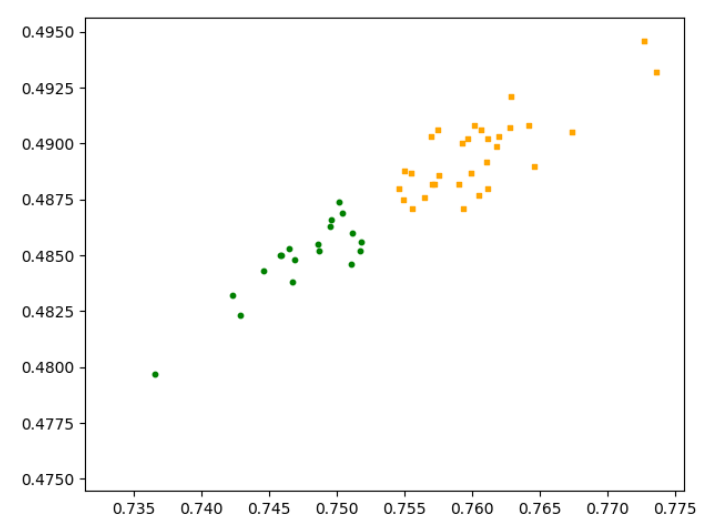
Figure 5. Classification result of the entity recognition algorithm based on deep belief networks.